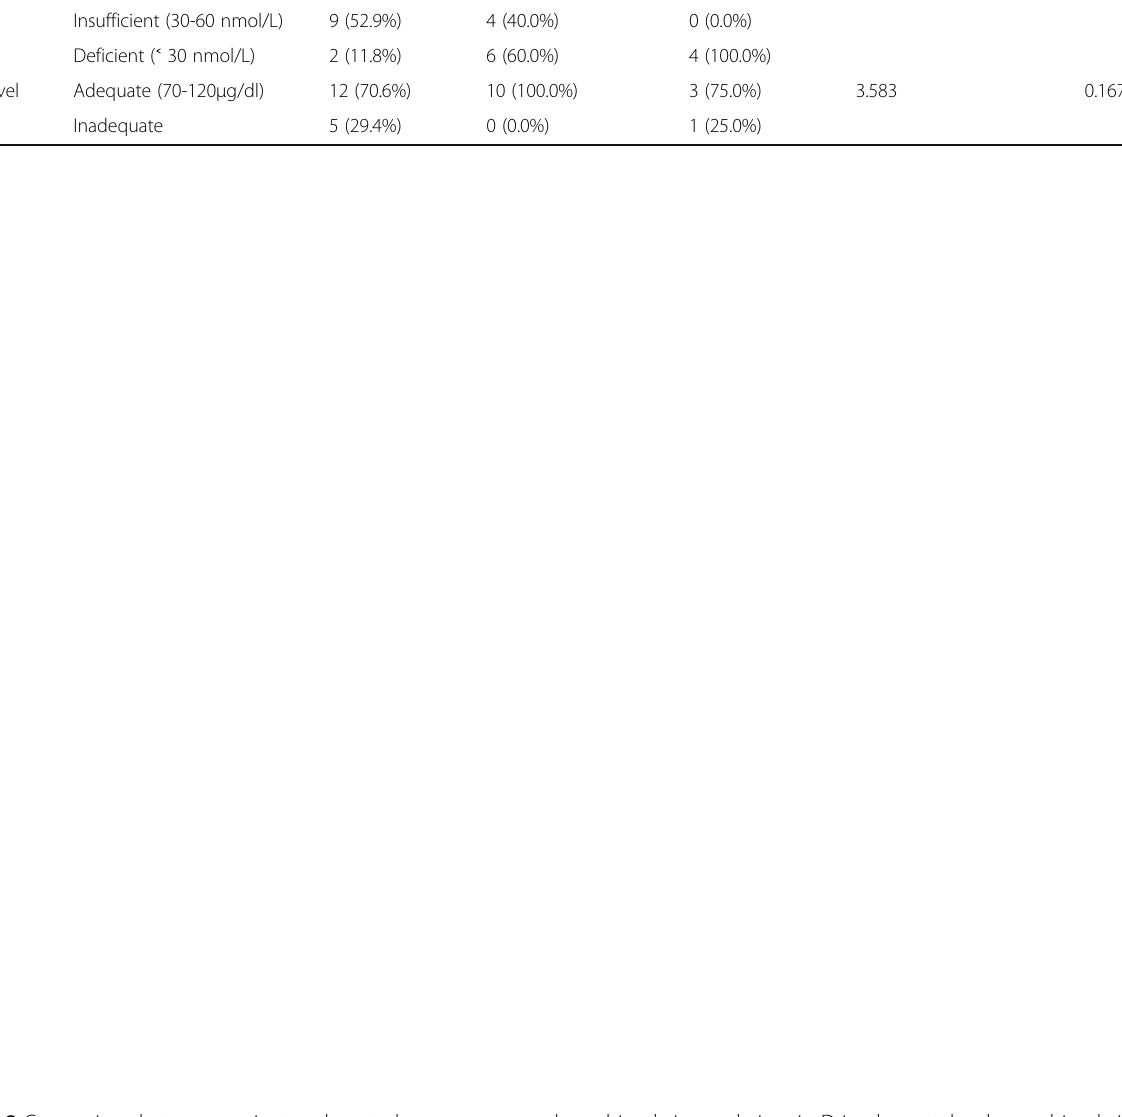
Table 8 Comparison between patient and control groups as regard combined zinc and vitamin D inadequate levels, combined zinc and TIBC inadequate levels, combined vitamin D and TIBC inadequate levels, inadequate all of them, and sufficient all of